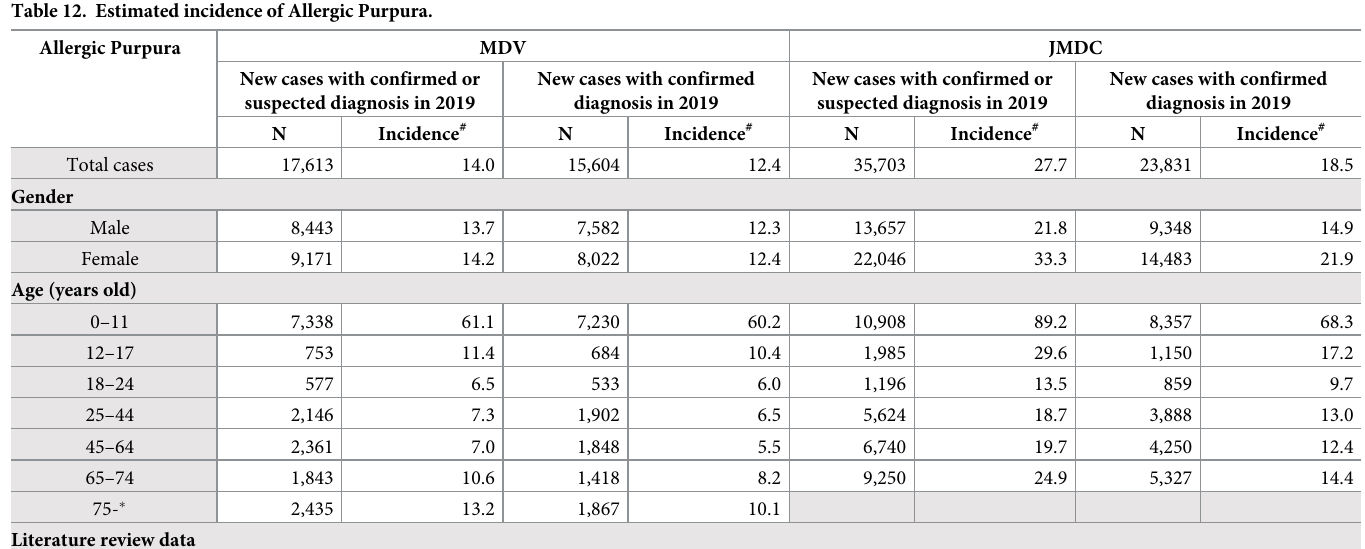
Table 12. Estimated incidence of Allergic Purpura.